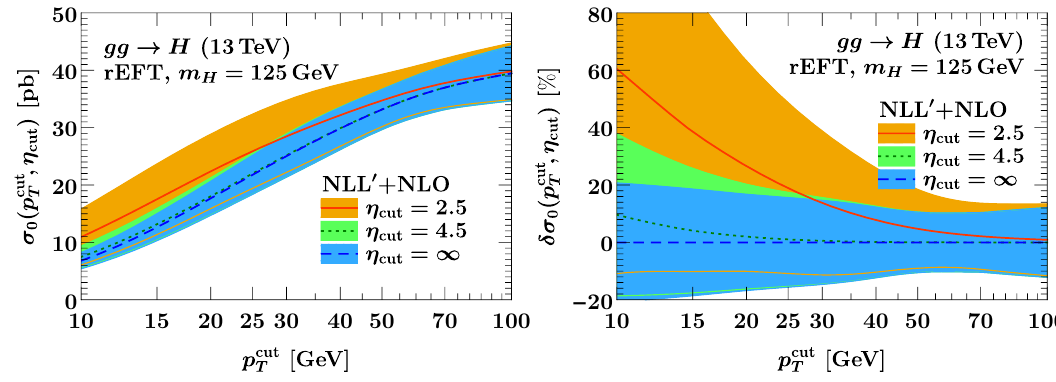
Figure 12 . 0-jet cross section (cid:27) 0 ( p cut di(cid:11)erent values of (cid:17) cut . The bands indicate the total uncertainty (cid:1) (cid:22) 0 cross section is shown on the left. On the right, the same results are shown as the percent di(cid:11)erence relative to the 0-jet cross section at (cid:17) cut =